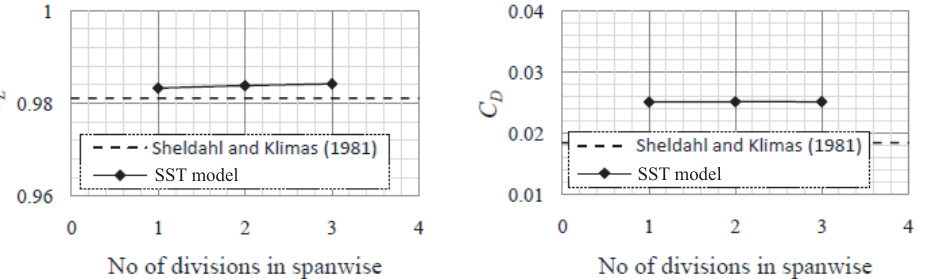
Figure 11. Variation in lift and drag as a function of airfoil edge sizing in the spanwise direction ( α = 10 ◦ , Re = 3.6 × 10 5